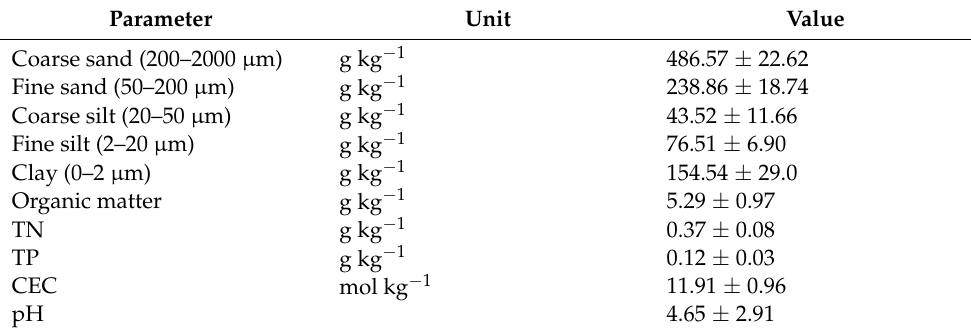
Table 1. Characteristics of the soil used in the present